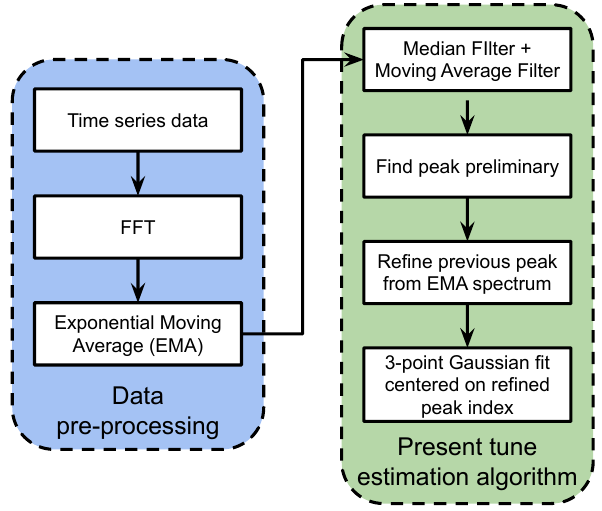
Figure 2. Present BQ tune estimation algorithm